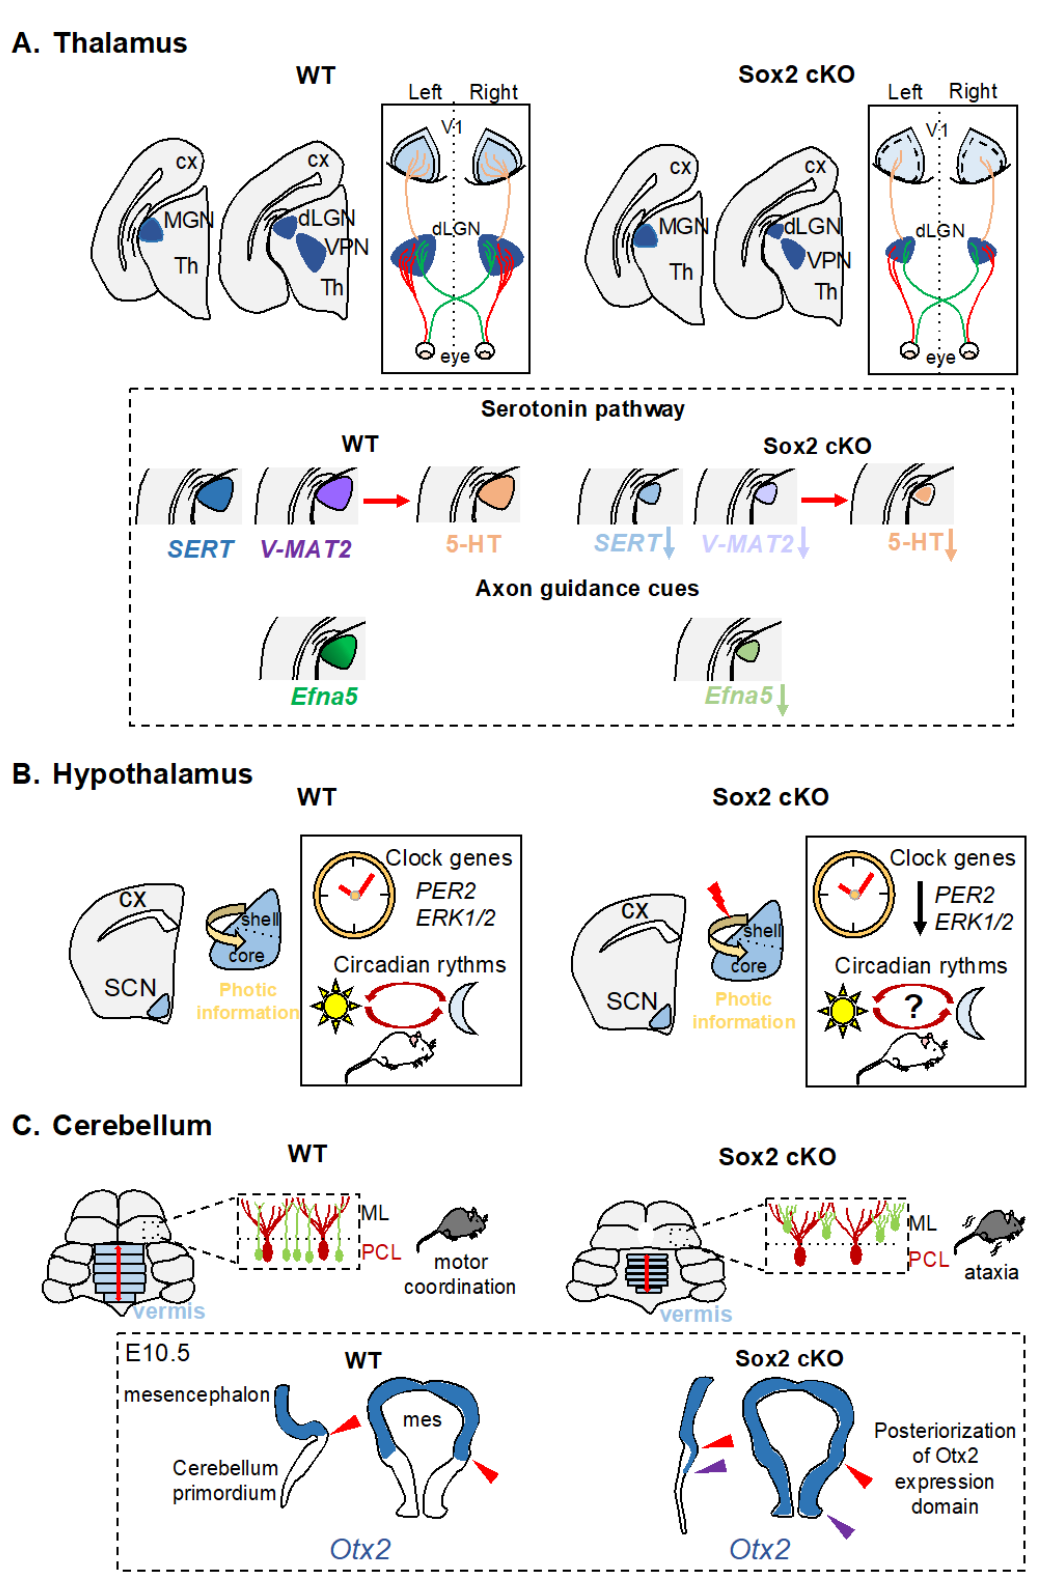
Figure 2. Schematic representation of defects arising from Sox2 deletion in the thalamus, hypothala- mus, and cerebellum of Sox2 cKO mice. ( A ) Thalamus. Sox2 thalamic KO, mediated by Roralpha- Cre, leads to ablation of Sox2 expression in the medial geniculate nucleus (MGN, auditory), the dorsolateral geniculate nucleus (dLGN, visual) and the ventroposterior nucleus (VPN, somatosen- sory). A reduction of the dLGN is observed in Sox2 cKO mice compared to controls (WT) and pro- jections from the mutant dLGN to the primary visual cortex (V1) are reduced, leading to a mis- patterned V1. The expression of components of the Serotonin pathway and of the axon guidance molecule Ephrin A5 (Efna5) is reduced in Sox2 thalamic mutants compared to controls. ( B ) Hypo- thalamus. Sox2 conditional deletions by VGAT-Cre in clock neurons in the suprachiasmatic nucleus (SCN) disrupts circadian rhythms and results in downregulation of clock genes ( Per2 and Erk1/2 ).